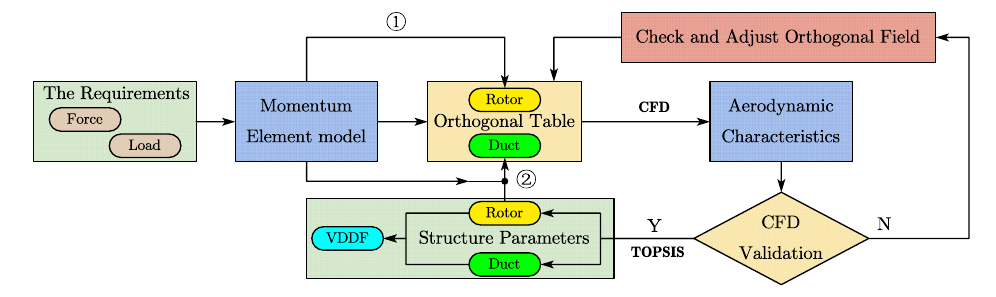
Figure 4. Orthogonal experiment flow.